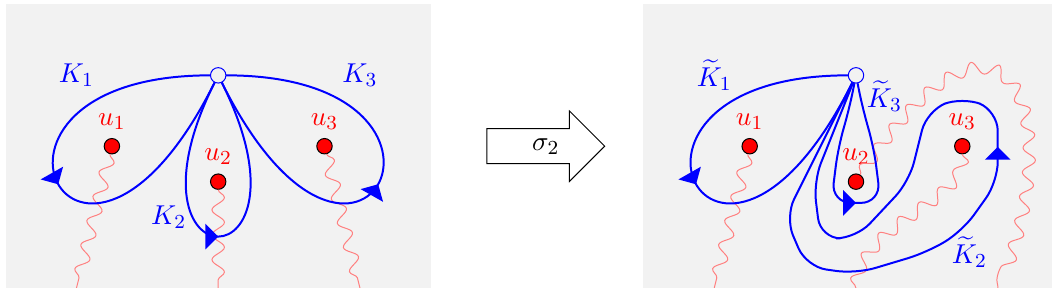
Figure 3 . Change of monodromy basis associated with (cid:27) 2 which moves the 2nd cut through the 3rd singularity. The new monodromies are related to the old by e K 1 = K 1 , e K 2 = K (cid:0) 1 e K 3 = K 2